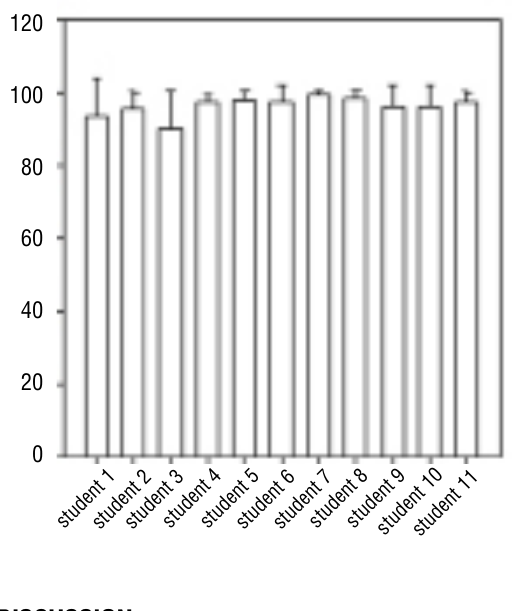
Figure 4 - Performance results of each student after 10 training sessions. All students reached the score of 80% of success, being 98% the maximum